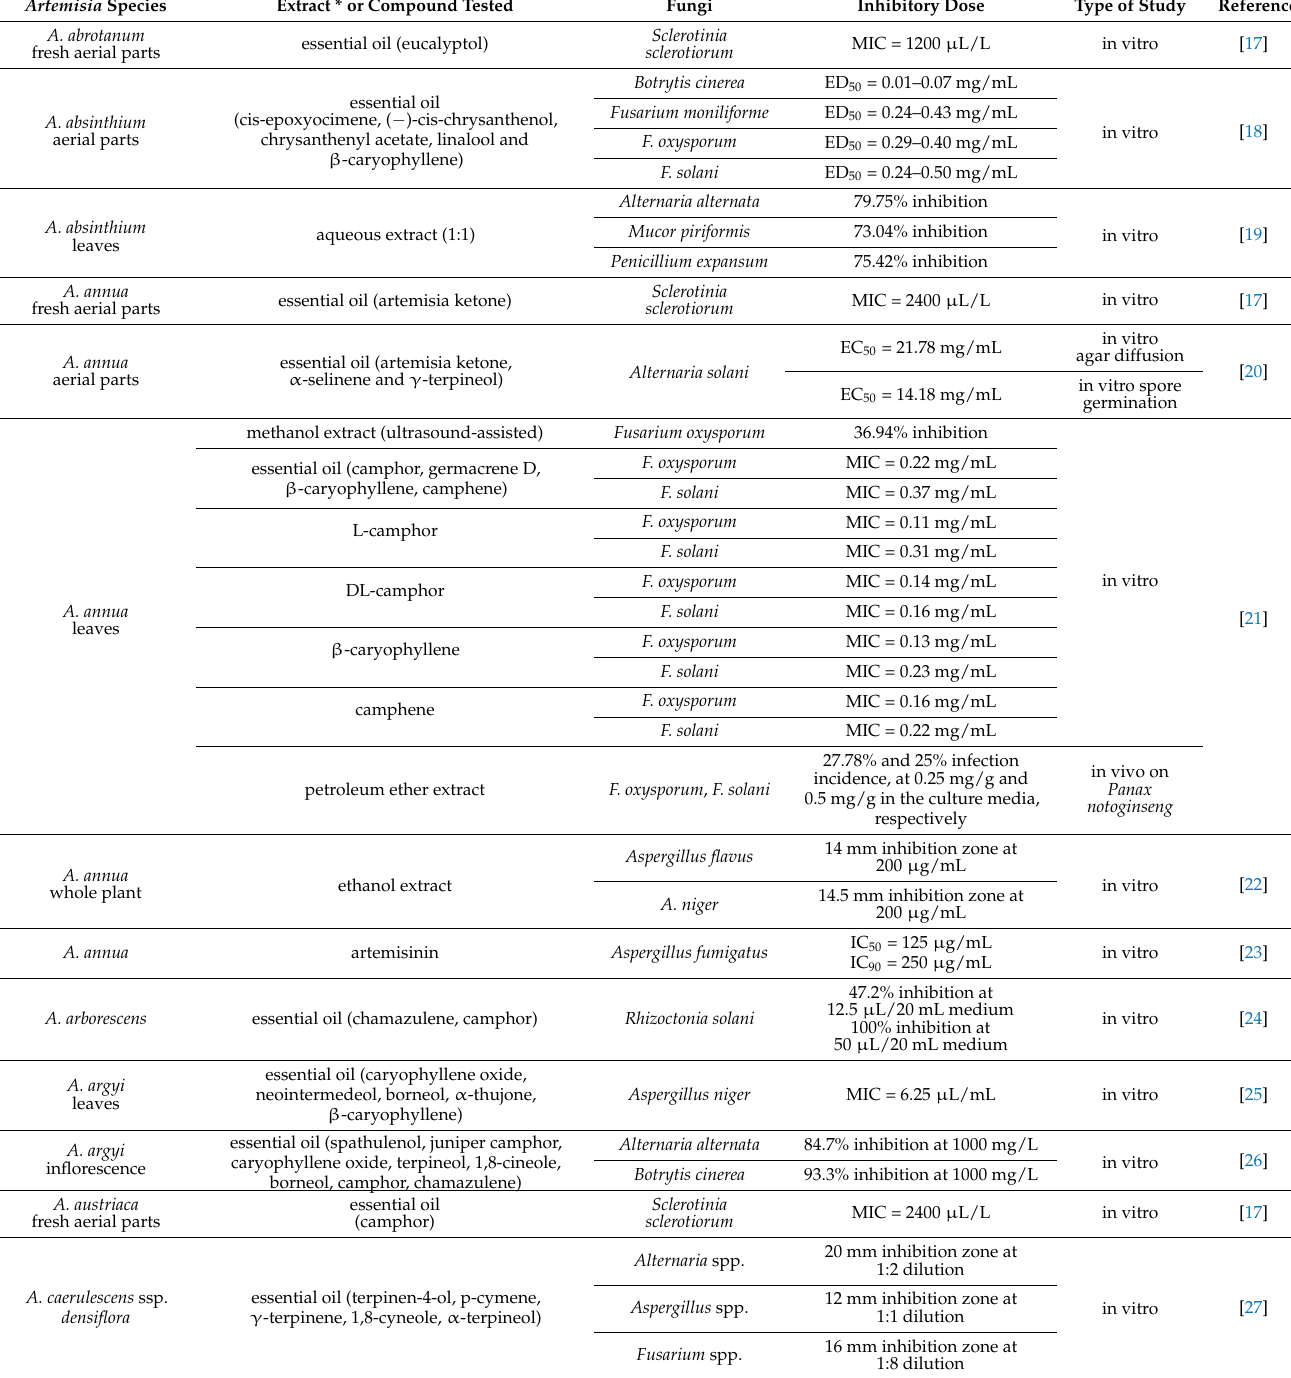
Table 1. Antifungal activity of Artemisia extracts and compounds against phytopathogenic